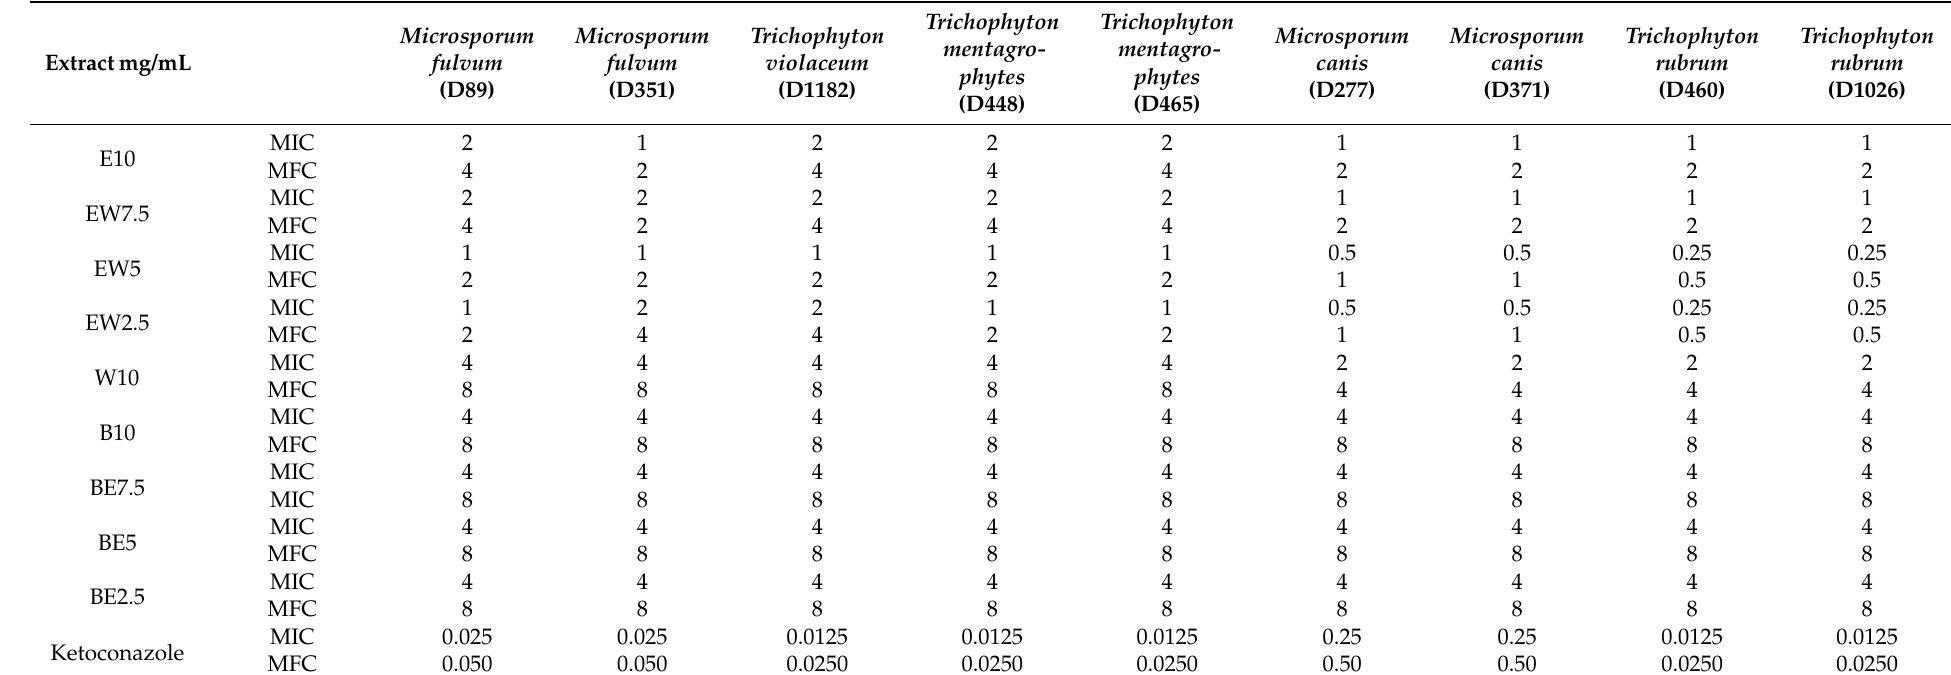
Table 5. Antifungal activity of different Allium scorodoprasum flower extracts against isolated dermatomycetes in